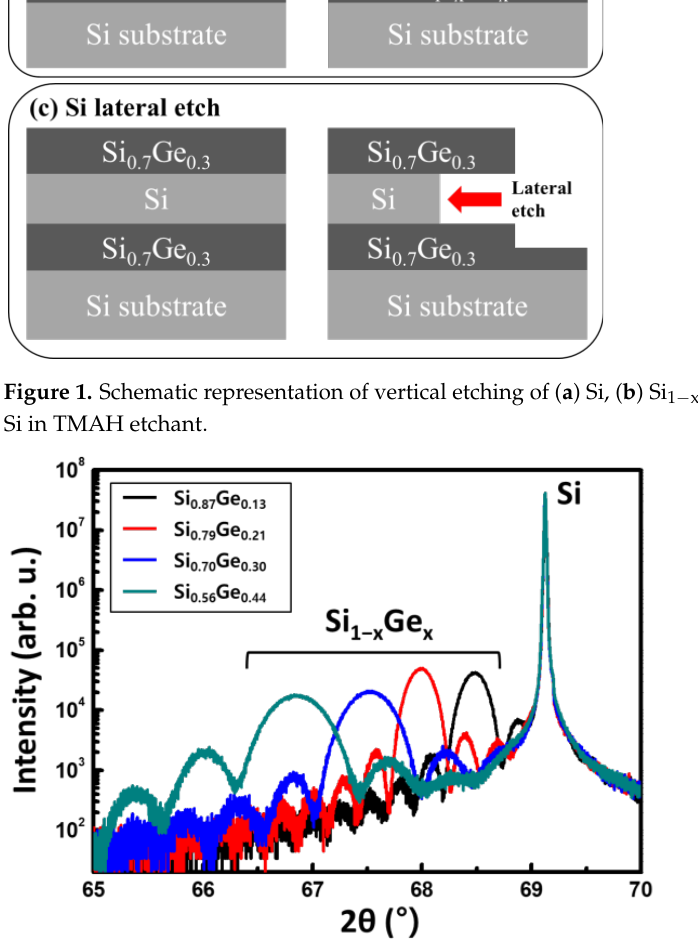
Figure 2. XRD (004) rocking curves of the Si 1 − x Ge x single-layers (x = 0.13, 0.21, 0.30, 0.44).